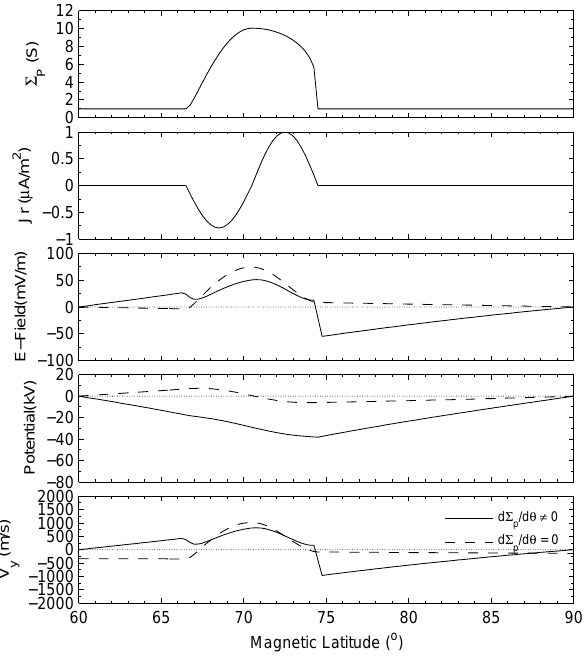
Fig. 8. Same as Fig. 1 except that Pedersen conductivity has a sin wave at the equatorward half and a sin 0 . 25 wave at the poleward half, which is a combination of the two conditions shown in Fig. 1. Field-aligned currents are kept